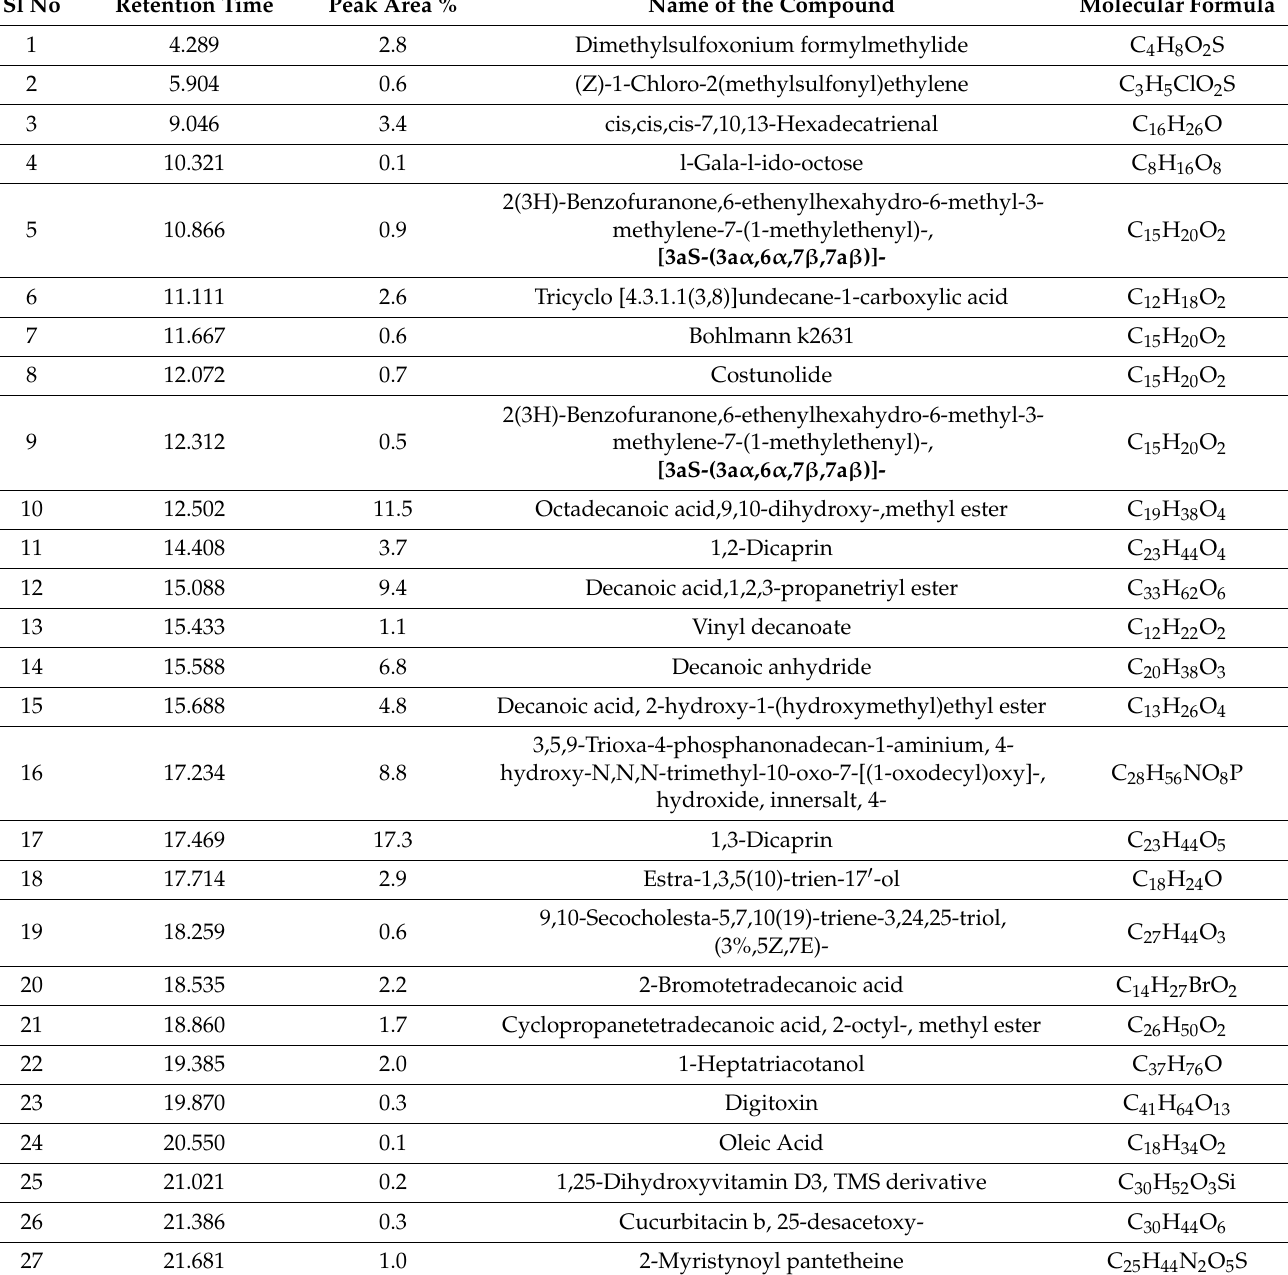
Table 4. Compounds present in n-butanol root extract of Saussurea lappa analyzed by